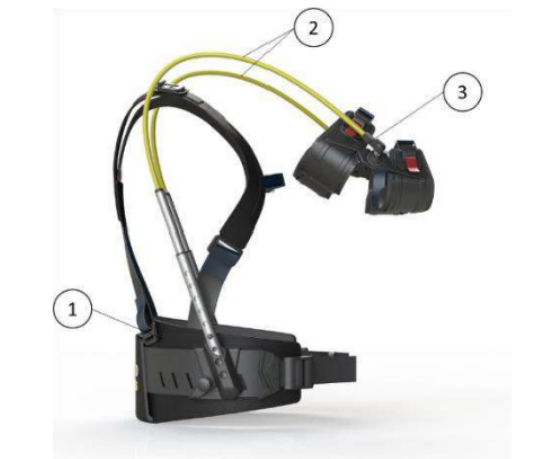
Figure 1. Description of Hapo MS ™ exoskeleton model (Le Tellier et al., 2021 [37]). (1) harness; (2) springs; (3)